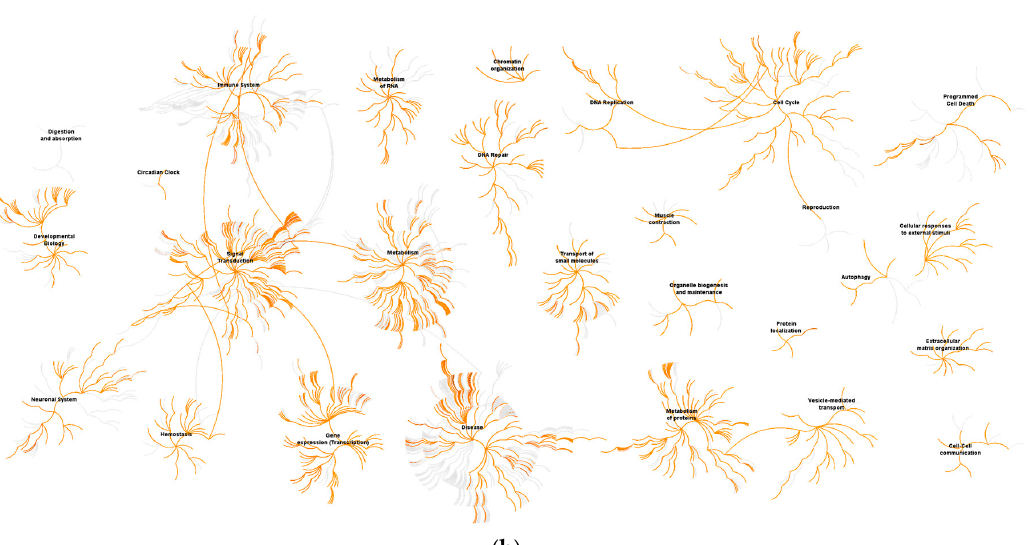
Figure 4. Reactome pathway diagram showing enriched signaling pathways as red lines. Genome-wide overview pathway analysis of ≥ two-fold downregulated genes for ( a ) ZIKV Polynesia and ( b ) ZIKV Uganda. The red lines denote over-representation of those pathways.